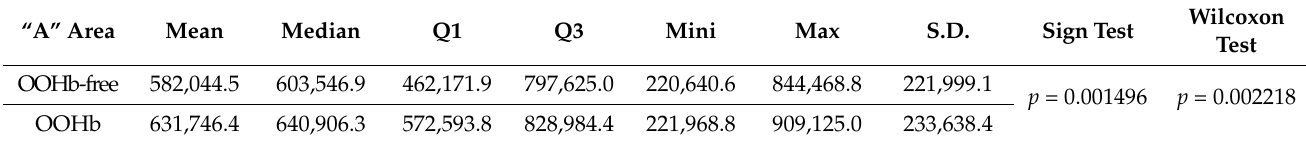
Table 3. The area “ A ” VVV statistical significance test results along with basic statistic summary. “A” Area